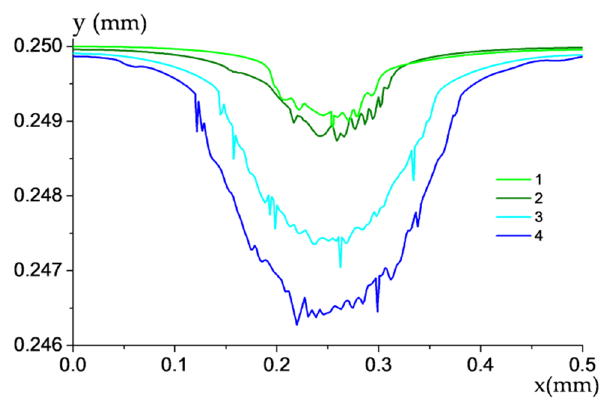
Figure 20. The wear track profiles of the PI/10CCF/10PTFE composite without pores (1, 3) and with them (2, 4) for different counterpart roughness; 0.1 μ m (1, 2) and 1 μ m (3, 4).